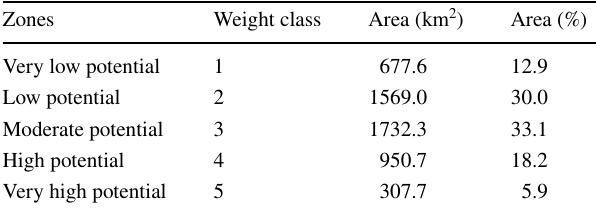
Table 3 Percent of the groundwater potential